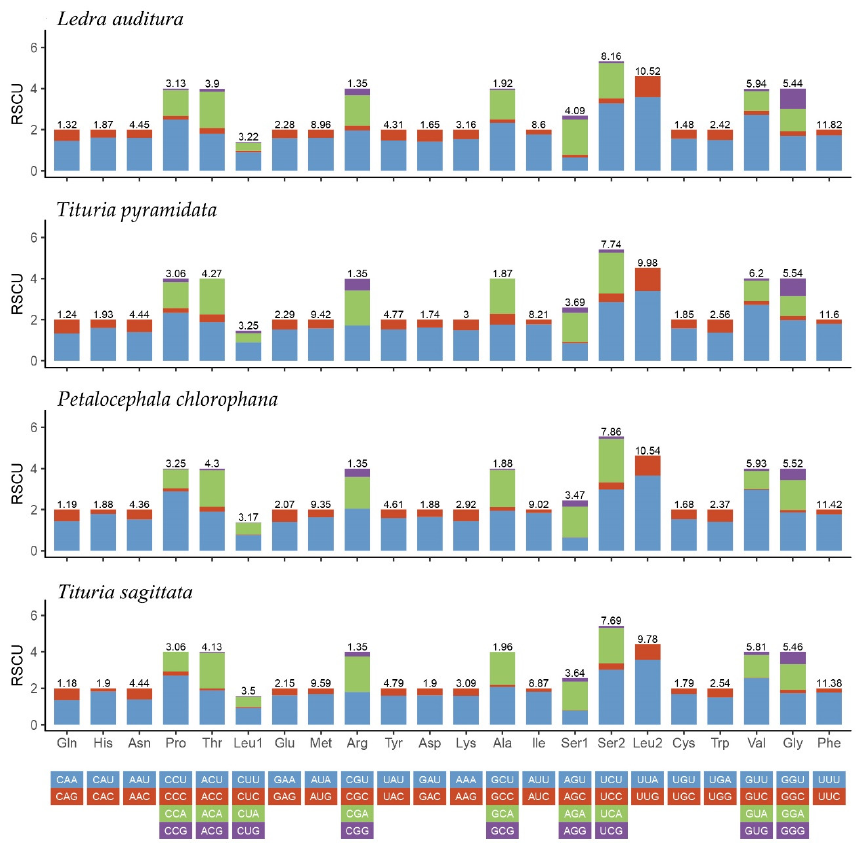
Figure 2. Relative synonymous codon usage (RSCU) of the mitogenomes of four Ledrinae